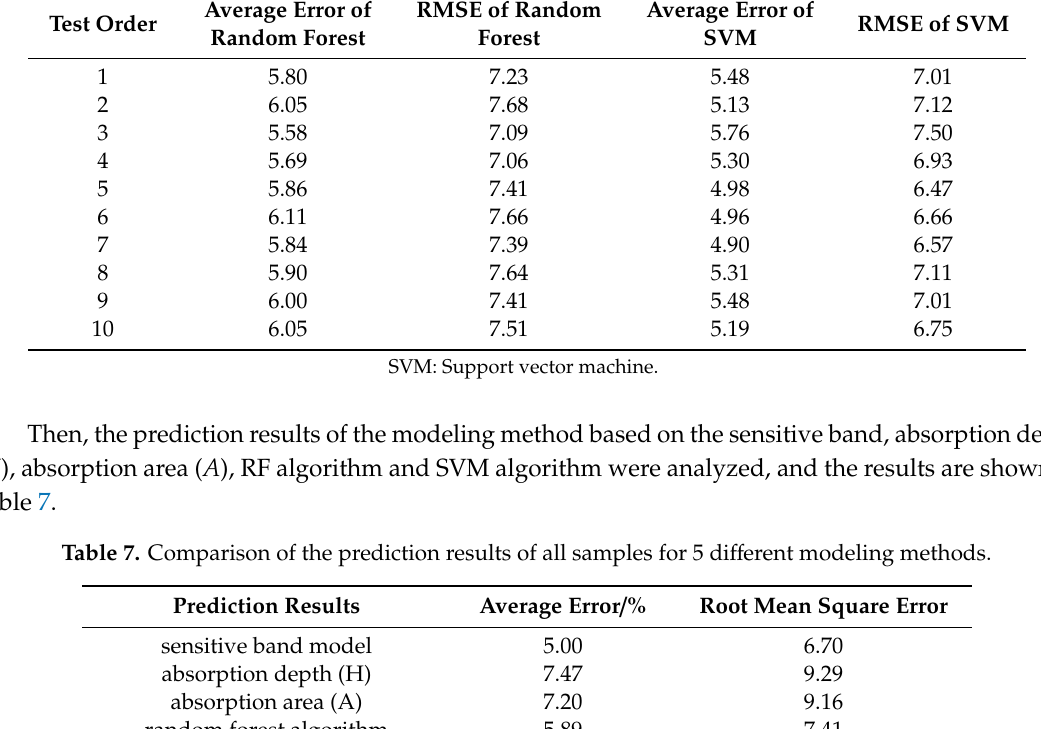
Table 6. Prediction results of random forest and support vector machine algorithms. Test Order